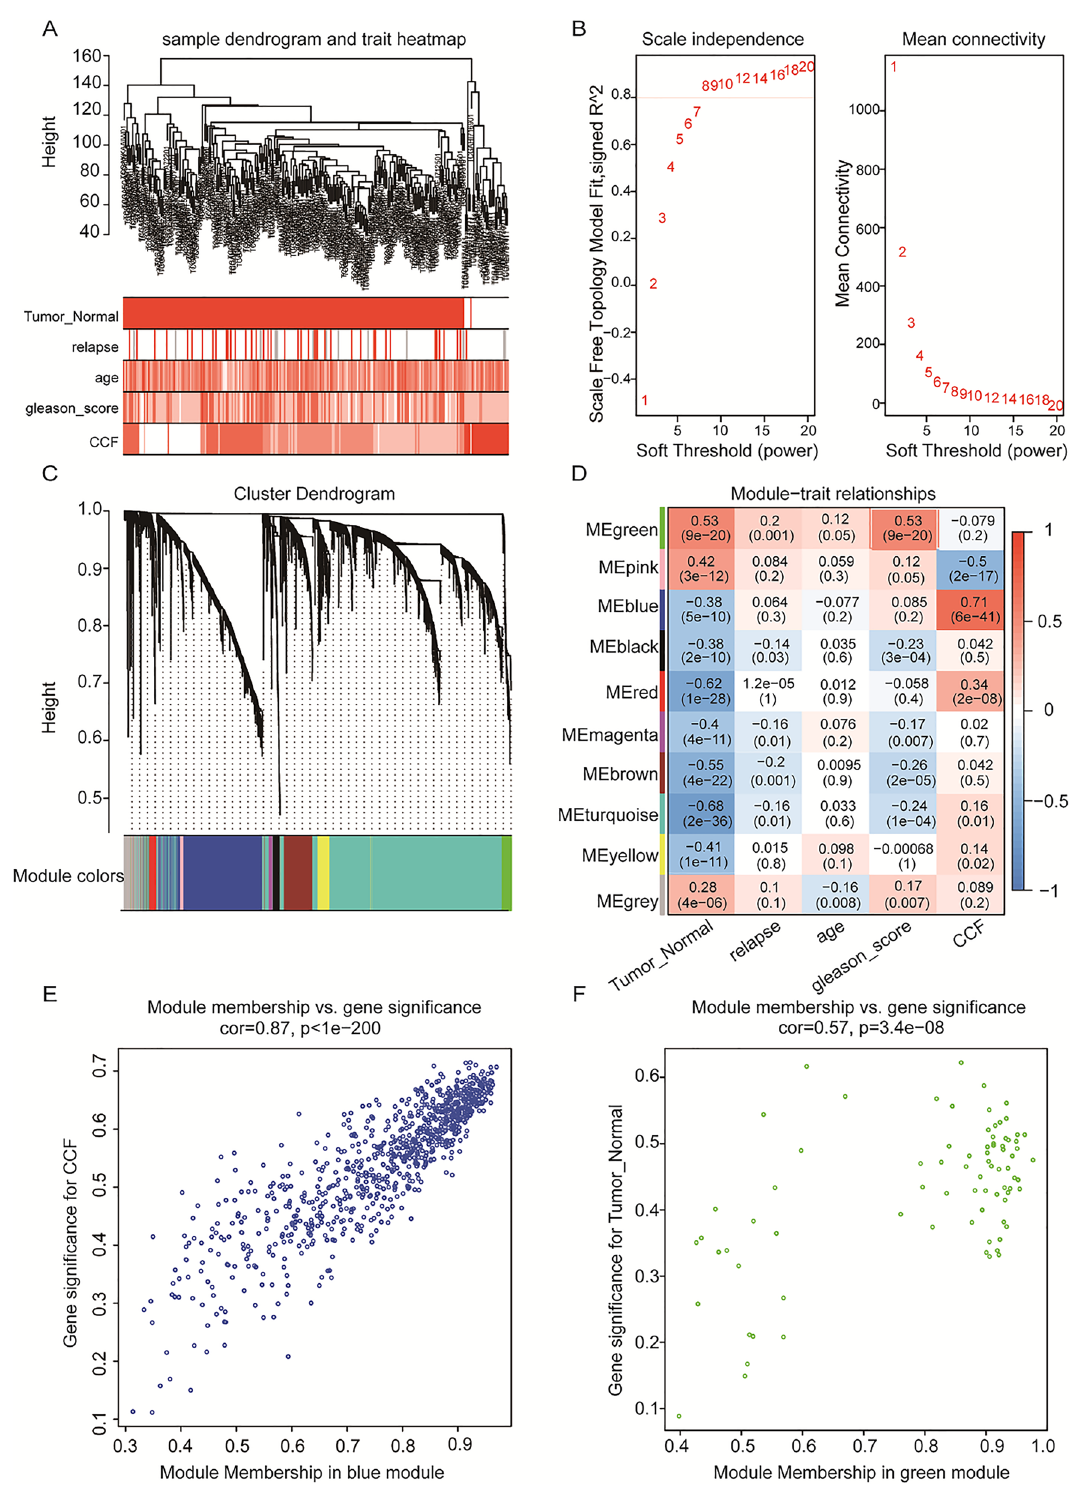
Figure 4. Analysis of weighted gene co-expression networks for the construction of PCa. ( A ). Dendrogram combining clinical data and transcriptional expression profiles for sample Euclidean distance clustering. ( B ). Analysis of soft threshold power for WGCNA: (left) Analysis of the scale-free matching index (β) for various soft threshold powers. (Right) Analysis of the average connectivity of various soft threshold powers. ( C ). Dendrogram of all differentially expressed genes clustered based on the measure of variability (1-TOM). The colors bands show the results obtained from the automated individual cluster analysis. ( D ). The heat map shows the relationship between MEs and clinical characteristics. Each cell contains the corresponding correlation coefficient and p-value. ( E , F ). Scatterplot of gene significance versus module affiliation in the three selected key modules blue, green